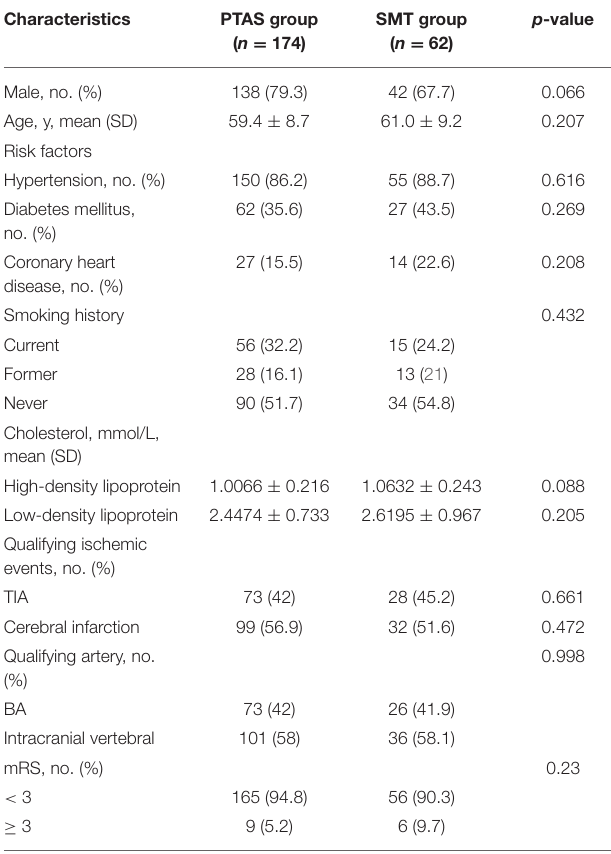
TABLE 2 | Baseline characteristics of the participants between PTAS and SMT